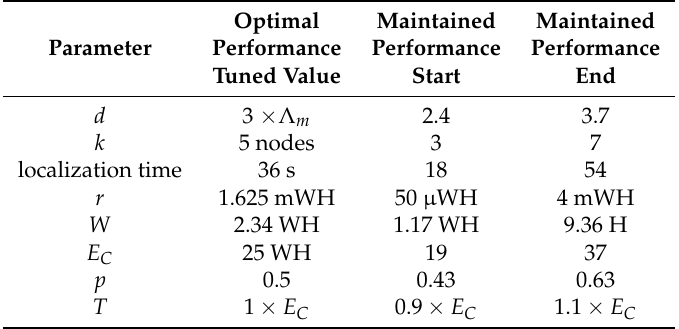
Table 4. ANLPP network parameter range